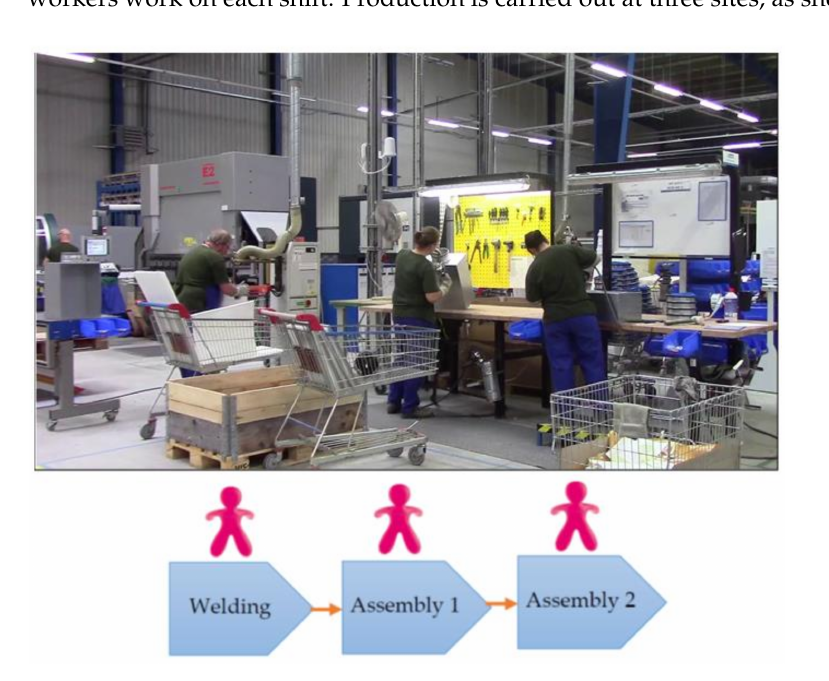
Figure 2. Production of fire dampers on the production